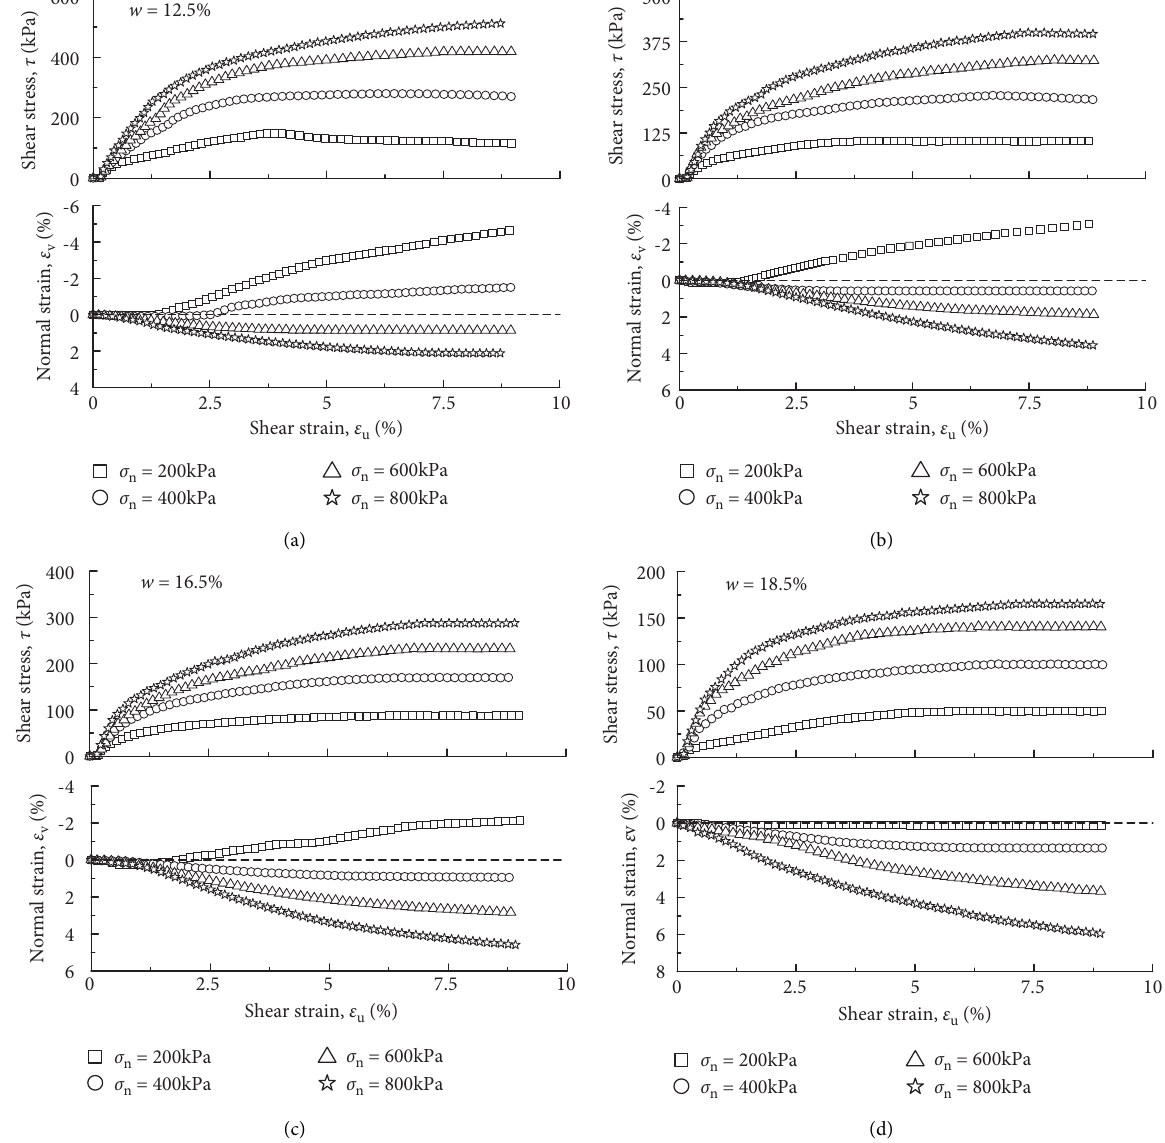
Figure 5: Test results of high plasticity clay-concrete interface. (a) w � 12.5%, (b) w � 14.5%, (c) w � 16.5%, and (d) w �